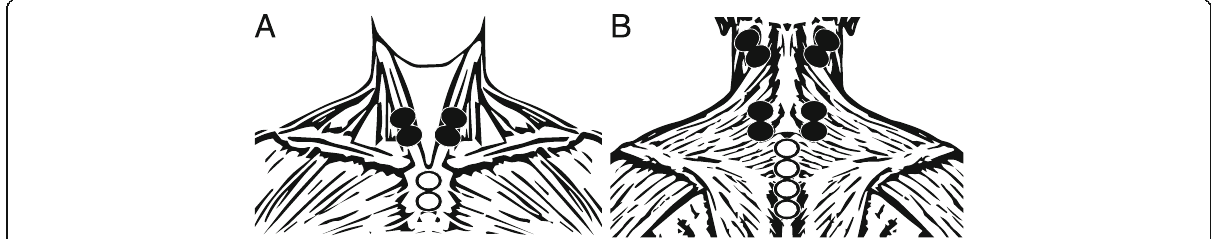
Fig. 1 Electrode placement for the anterior ( a ) and the posterior ( b ) neck. Filled and unfilled circles mark detection and reference electrodes, respectively